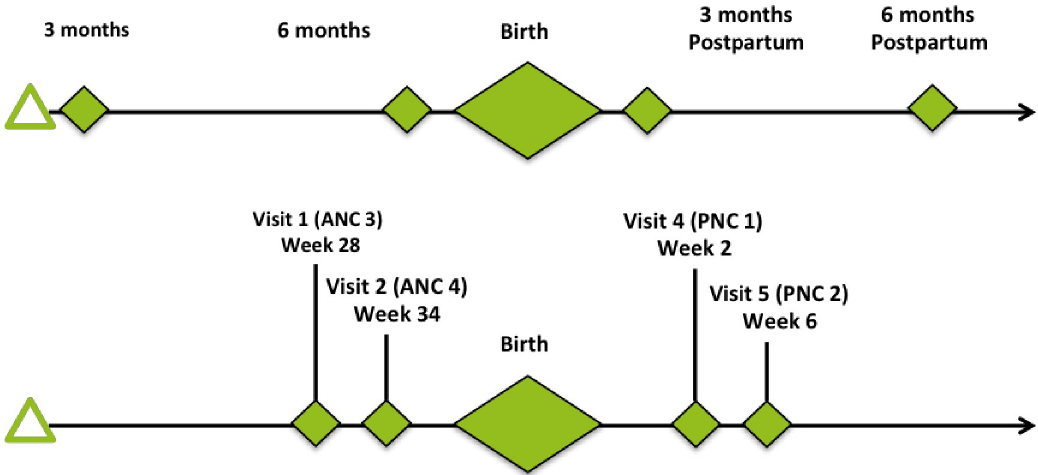
Fig 1. Adaptation of pilot timeline. The top timeline is recommended by the ICHOM Pregnancy and Childbirth Standard Set and spans from the third month of pregnancy until 6 months postpartum. The revised timeline adapted to the Kenyan context and used in the pilot starts at the 28th week of pregnancy and ends 6 weeks postpartum. The new timeline was adopted in line with the existing patient pathway for maternal health management in Nairobi. The green diamonds represent data collection points that coincide with clinic